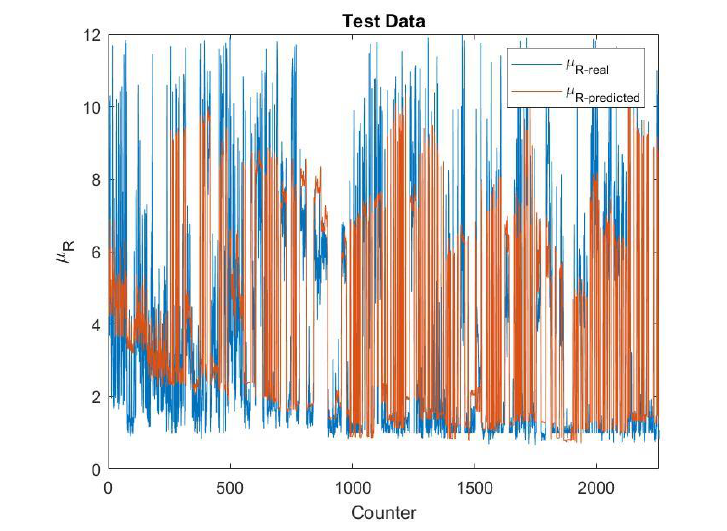
Figure 14. Comparison between the real and predicted value of ( μ R ) in testing data (FCM method) To evaluate the model's efficiency and accuracy, various error criteria, including Error, Mean Error, RMSE, MARE%, and R, are applied between model and real values in the testing data. The results are presented in Table 8. It is again observed that the model created by FCM is more accurate than the model created based on Subtractive